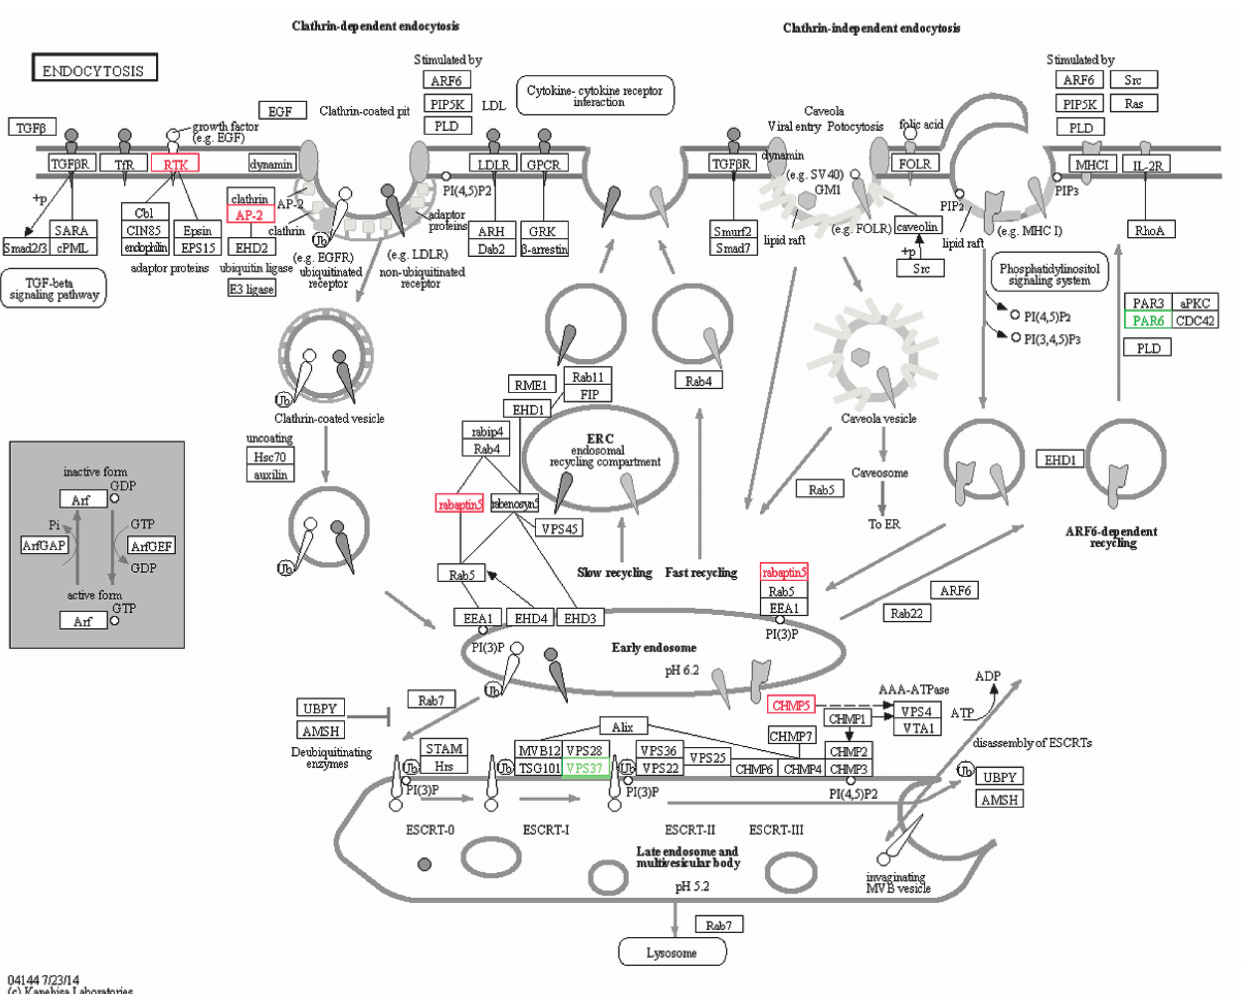
Figure 13. Endocytosis signaling pathway. Red boxes represent up-regulated genes, and green boxes represent down-regulated